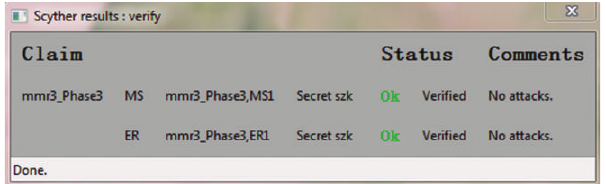
Figure 8: Verification result for Protocol 3-Phase 1, initial authenti- cation.